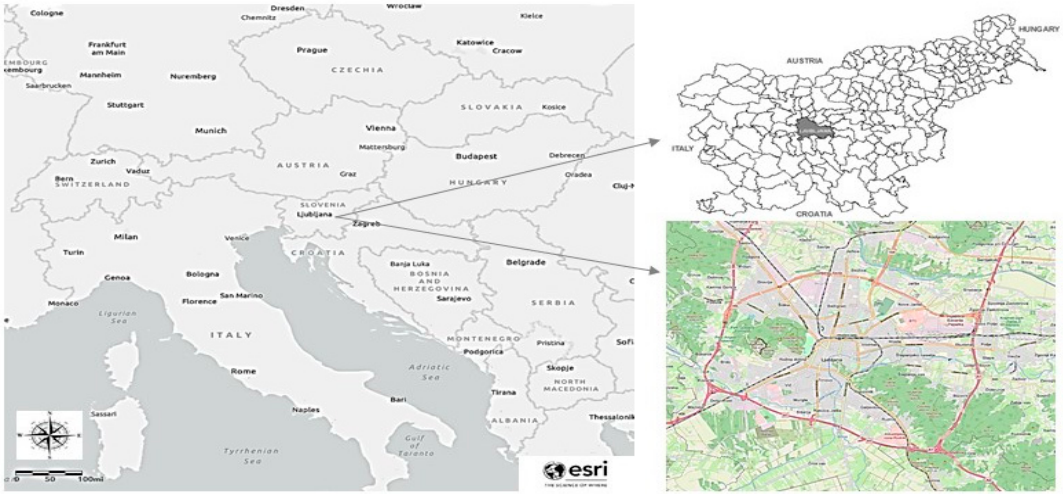
Figure 1. A map of Slovenia surrounded by bordering countries as well as the location of the capital city Ljubljana with the borders of the municipality, hydrography, and roads.